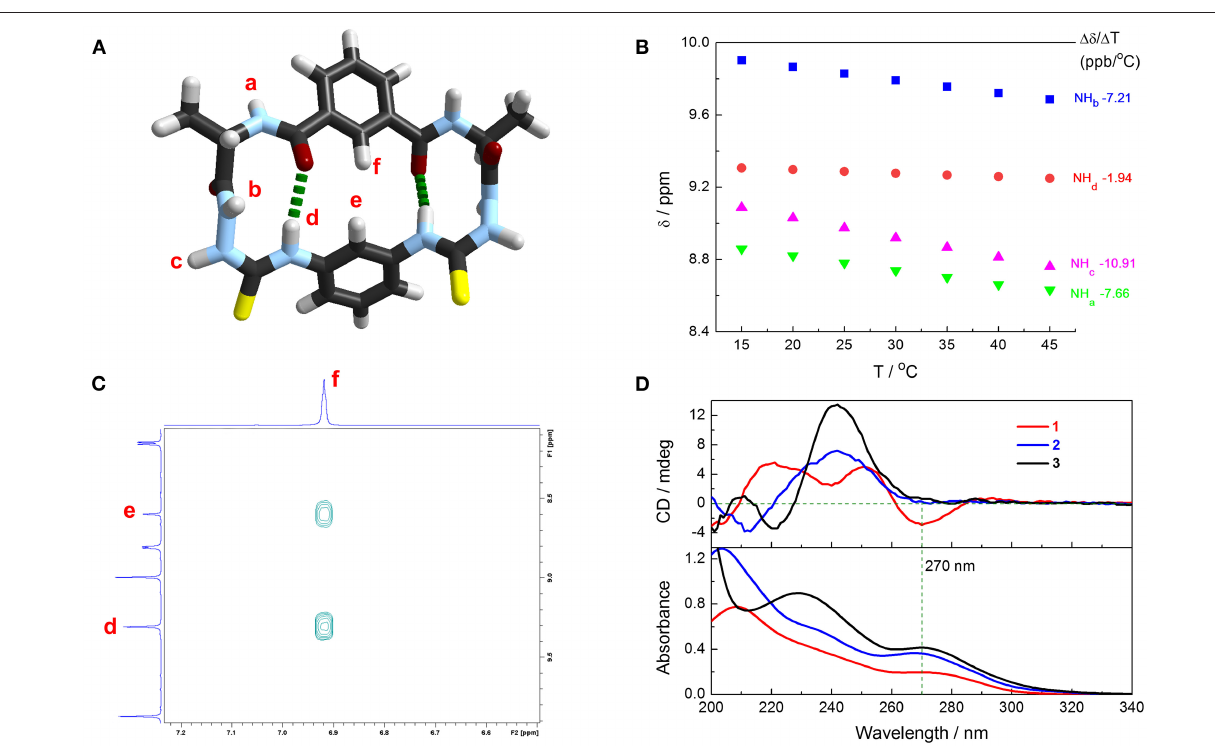
chromophore in 1 , deduced from the absorption spectra ( Figure 2D ). Meanwhile, the cyclic conformation also leads to higher lipophilicity of 1 , supported by their retention